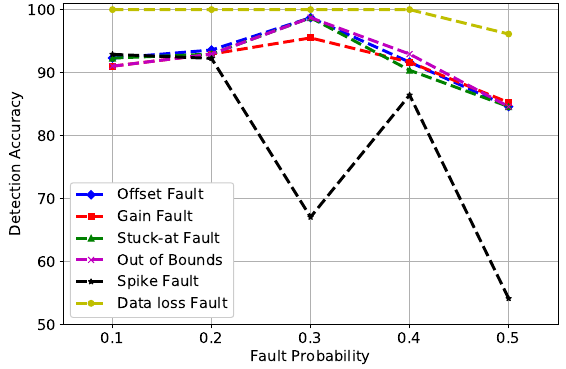
Figure 3. SVM detection accuracy of fault types.